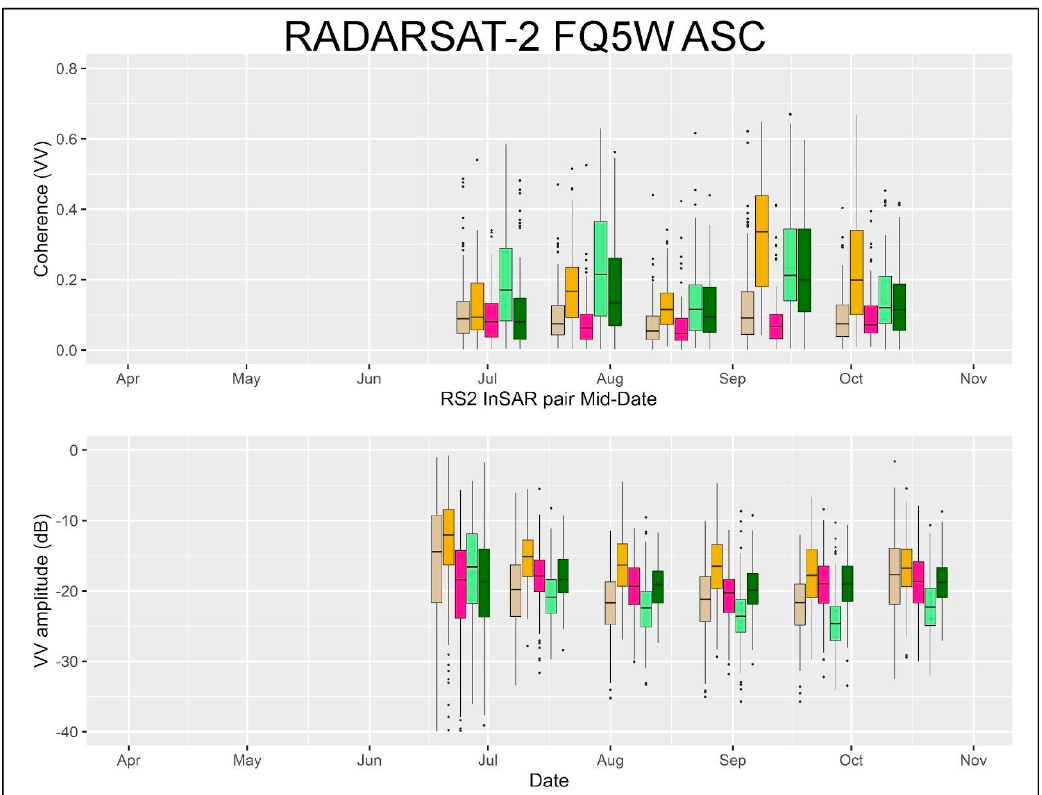
Figure 3. Example of coherence and amplitude of RADARSAT-2 FQ5 Ascending (ASC) mode and Sentinel-1 VV imagery during the growing season of 2017 by class. Date for each image acquisition is at the mid-point of the group of boxplots (e.g., for RS2 FQ5ASC mode imagery, the first image is acquired on 20 June 2017).